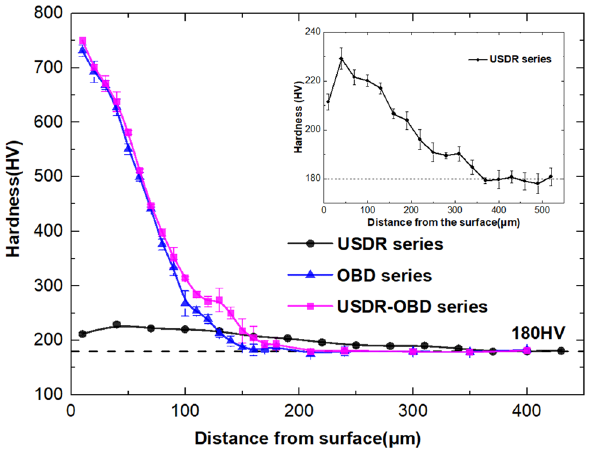
Figure 2. Microhardness along the distance from surface of USDR series, OBD series and USDR-OBD series.